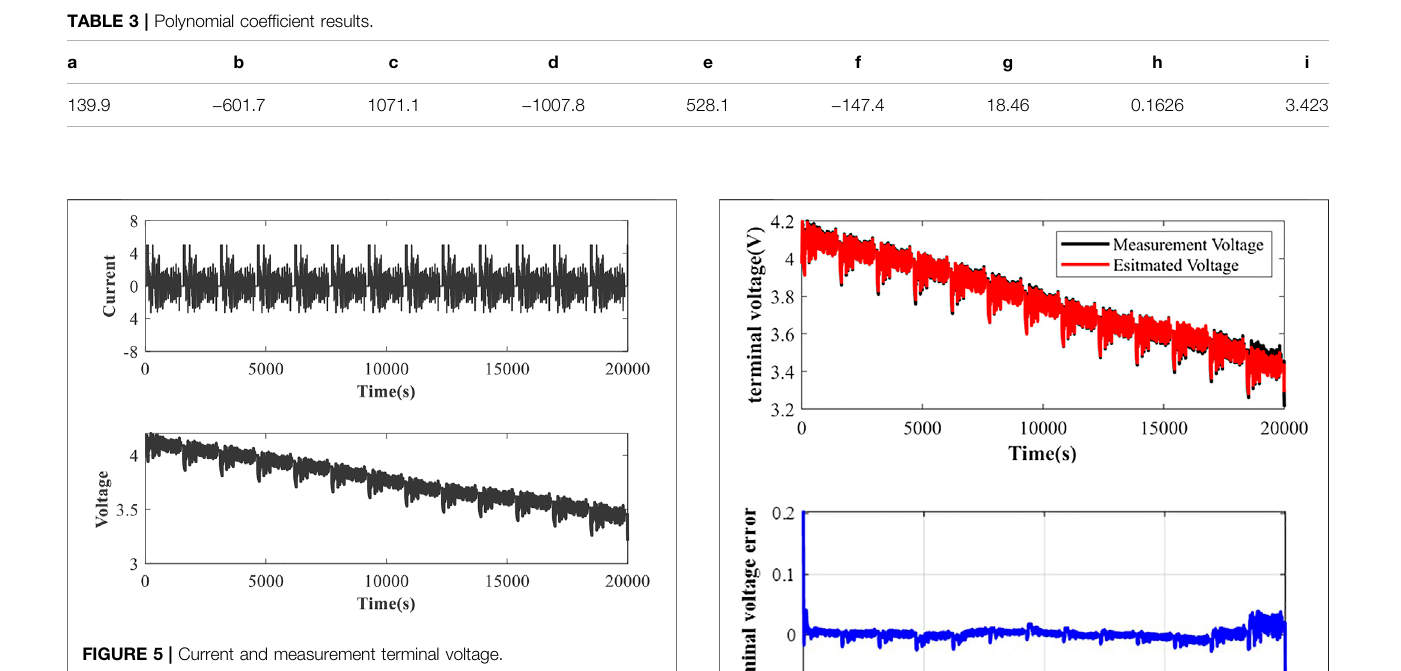
FIGURE 5 | Current and measurement terminal voltage.